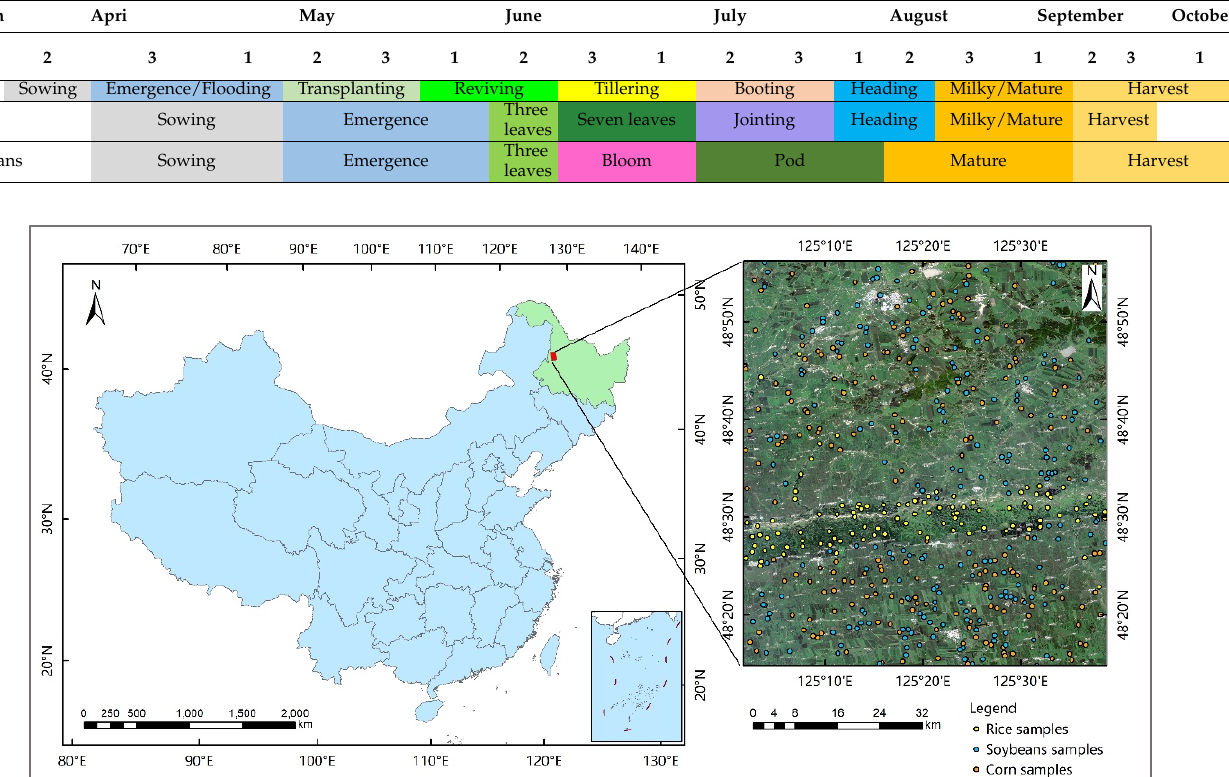
Figure 1. The geographical location of the region. Table 1. Phenological periods of main crops in the studied region.